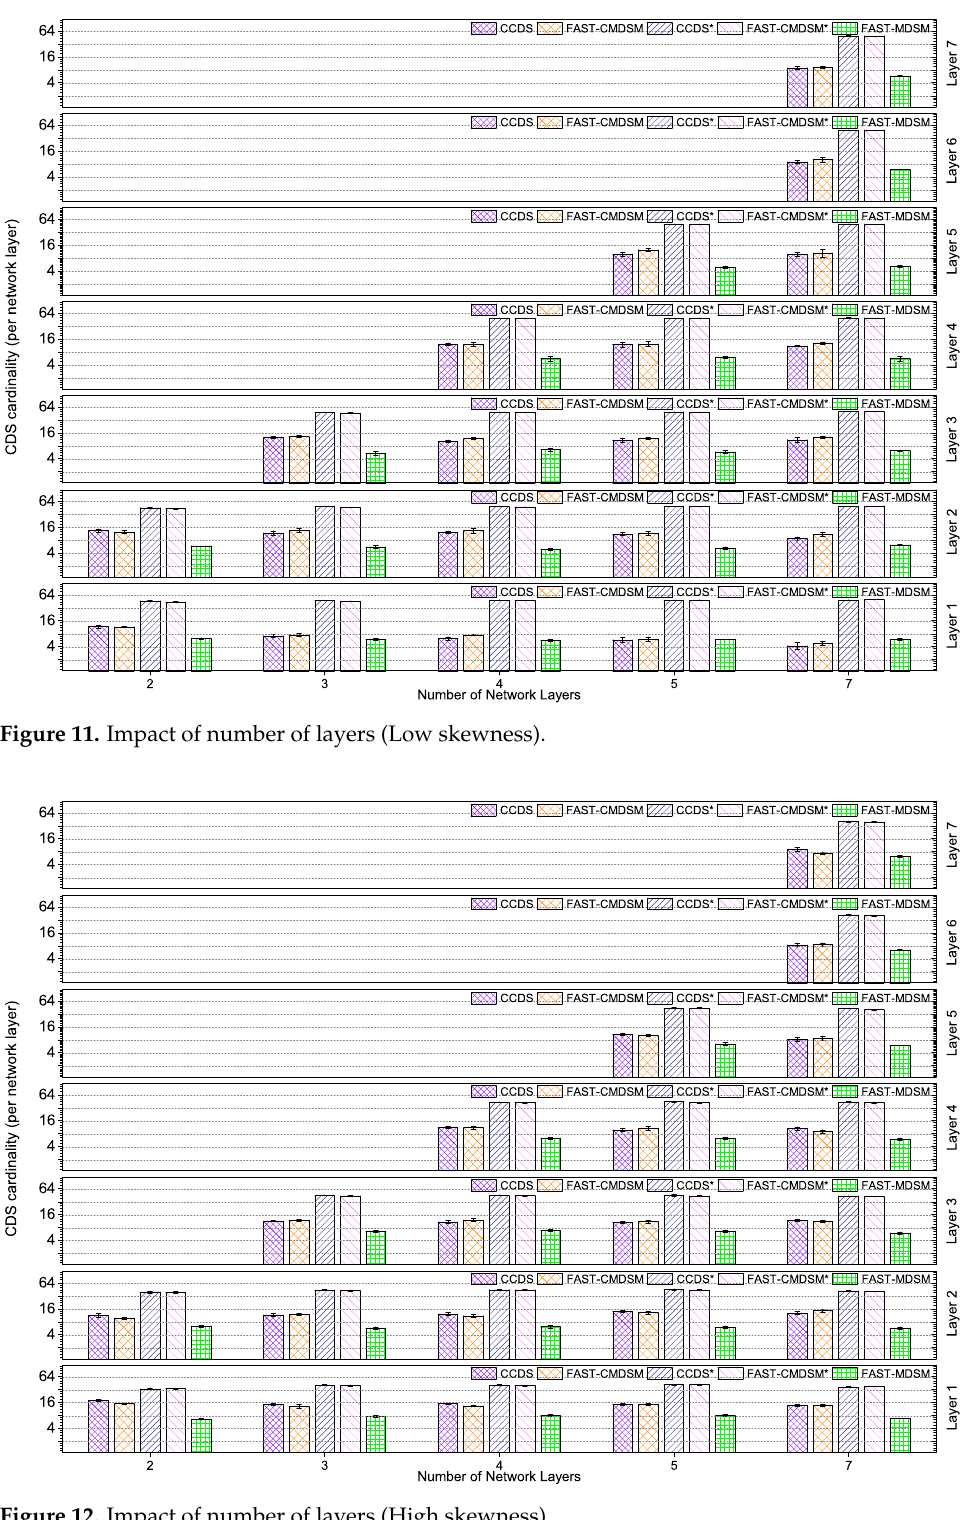
Figure 12. Impact of number of layers (High